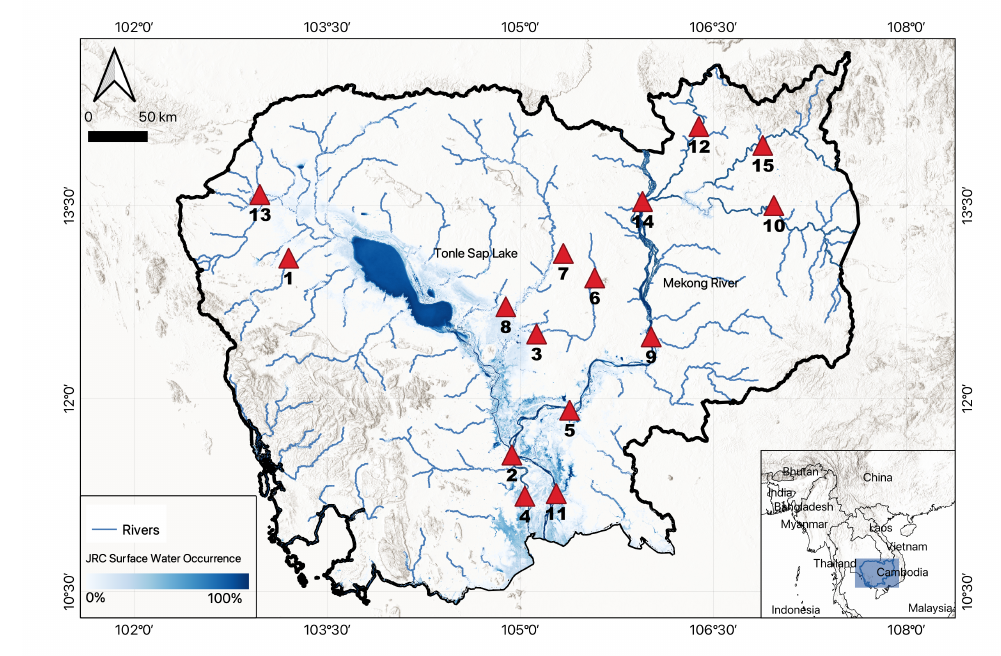
Figure 1. The red triangle indicates the gauge locations for which we developed the rating curve in Cambodia. The map also shows the surface water occurrence taken from European Commission’s Joint Research Centre (JRC) and the major river networks in the